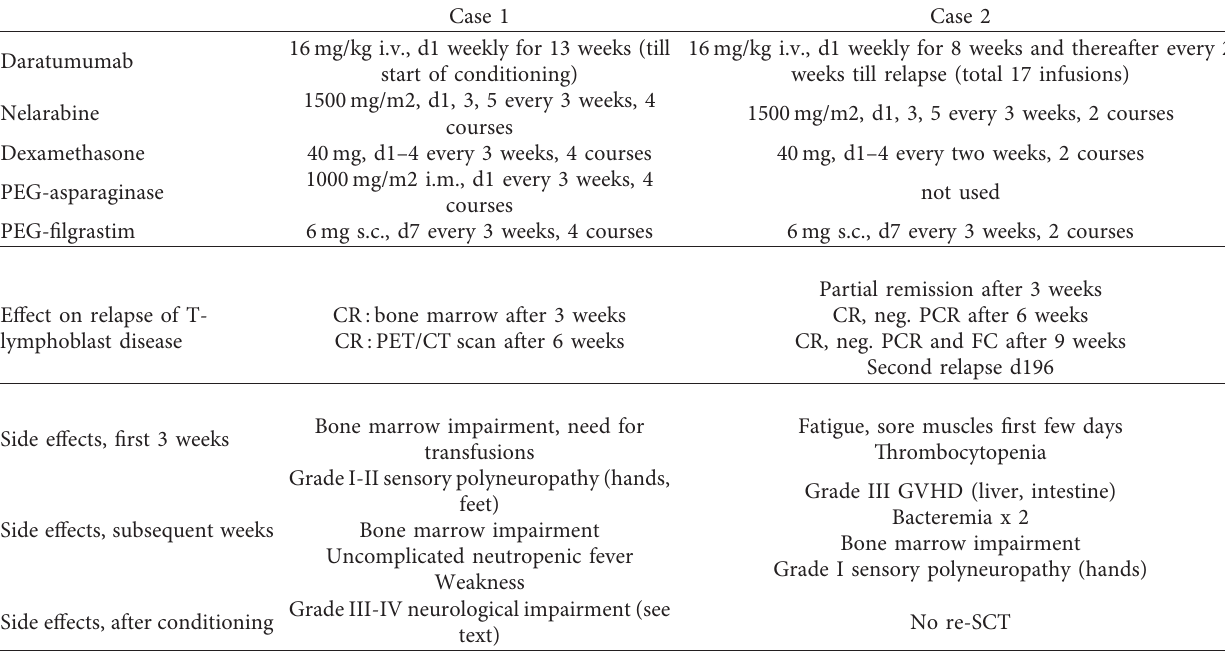
Table 1: Overview of salvage therapy with daratumumab/nelarabine